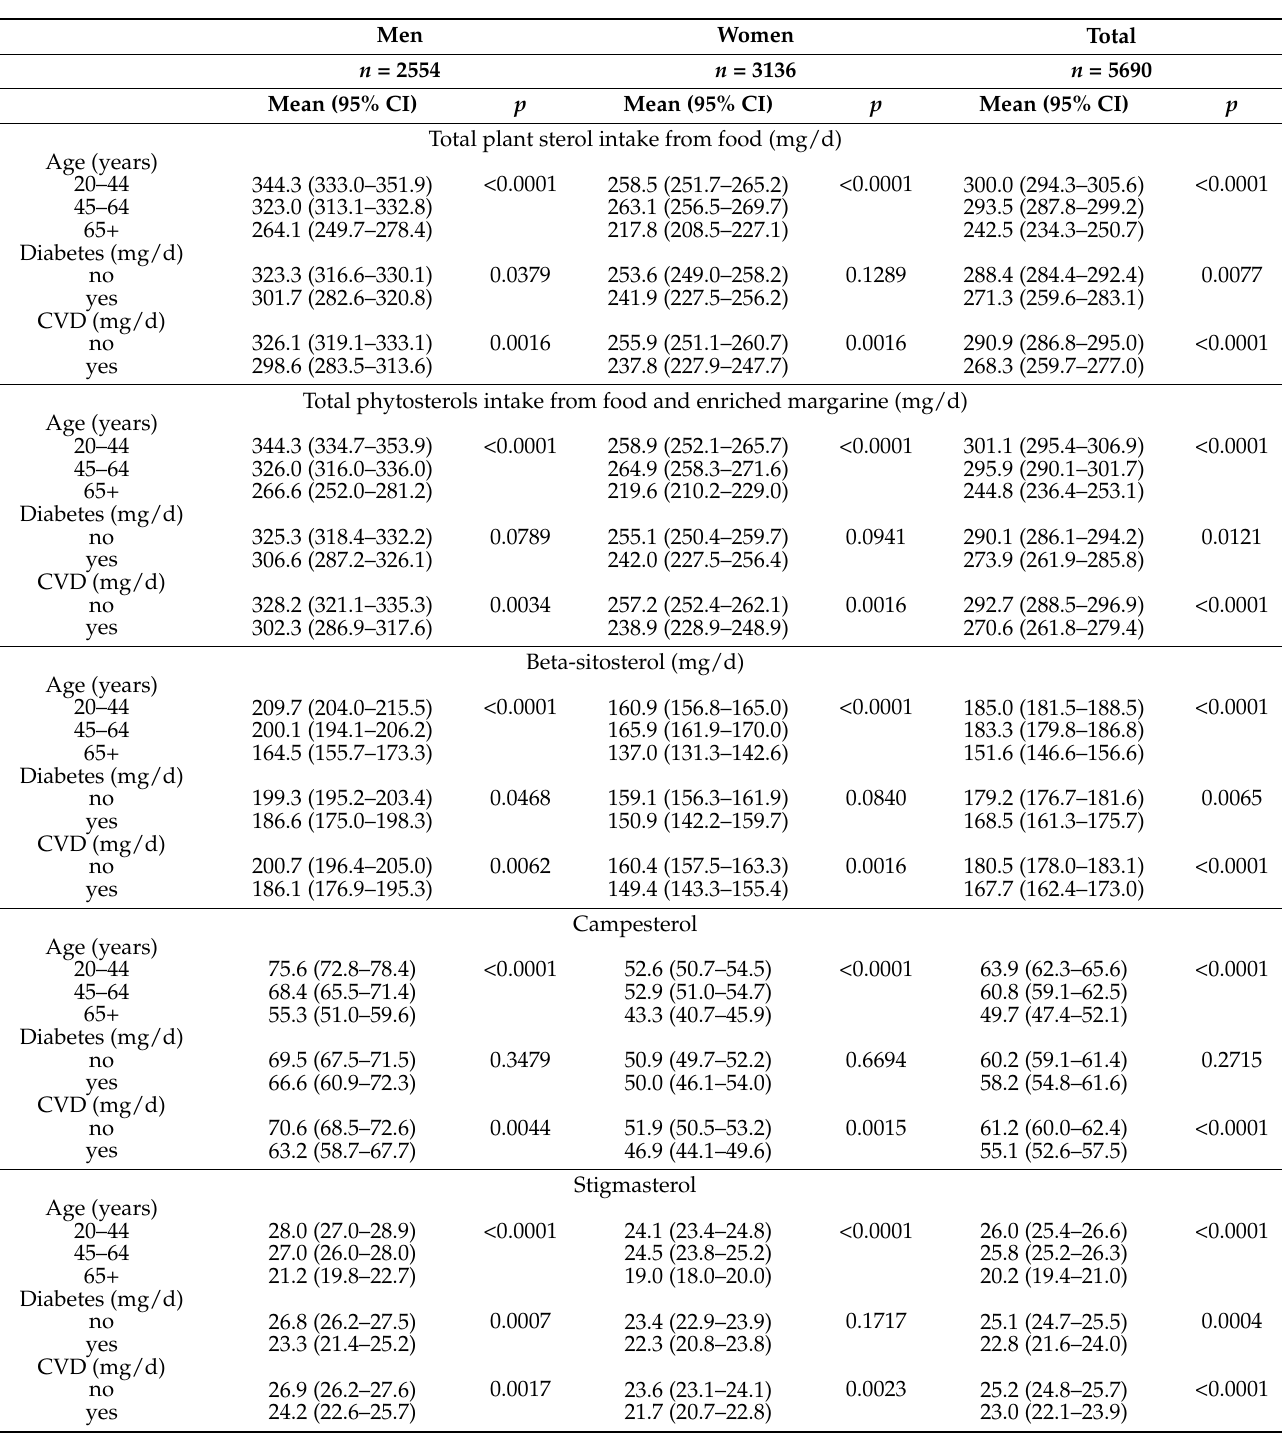
Table 2. Phytosterol intakes depending on age, diabetes, and